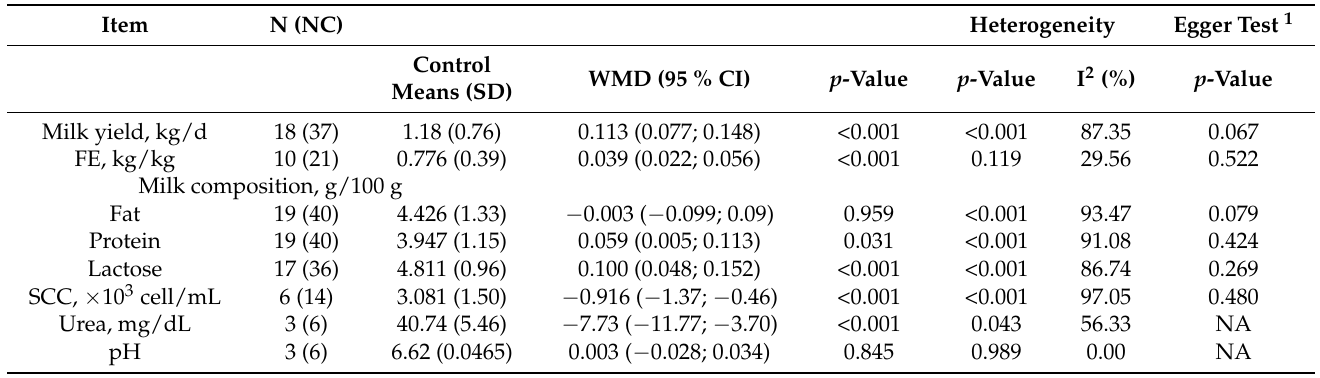
Table 7. Milk yield and quality of small ruminants supplemented with essential